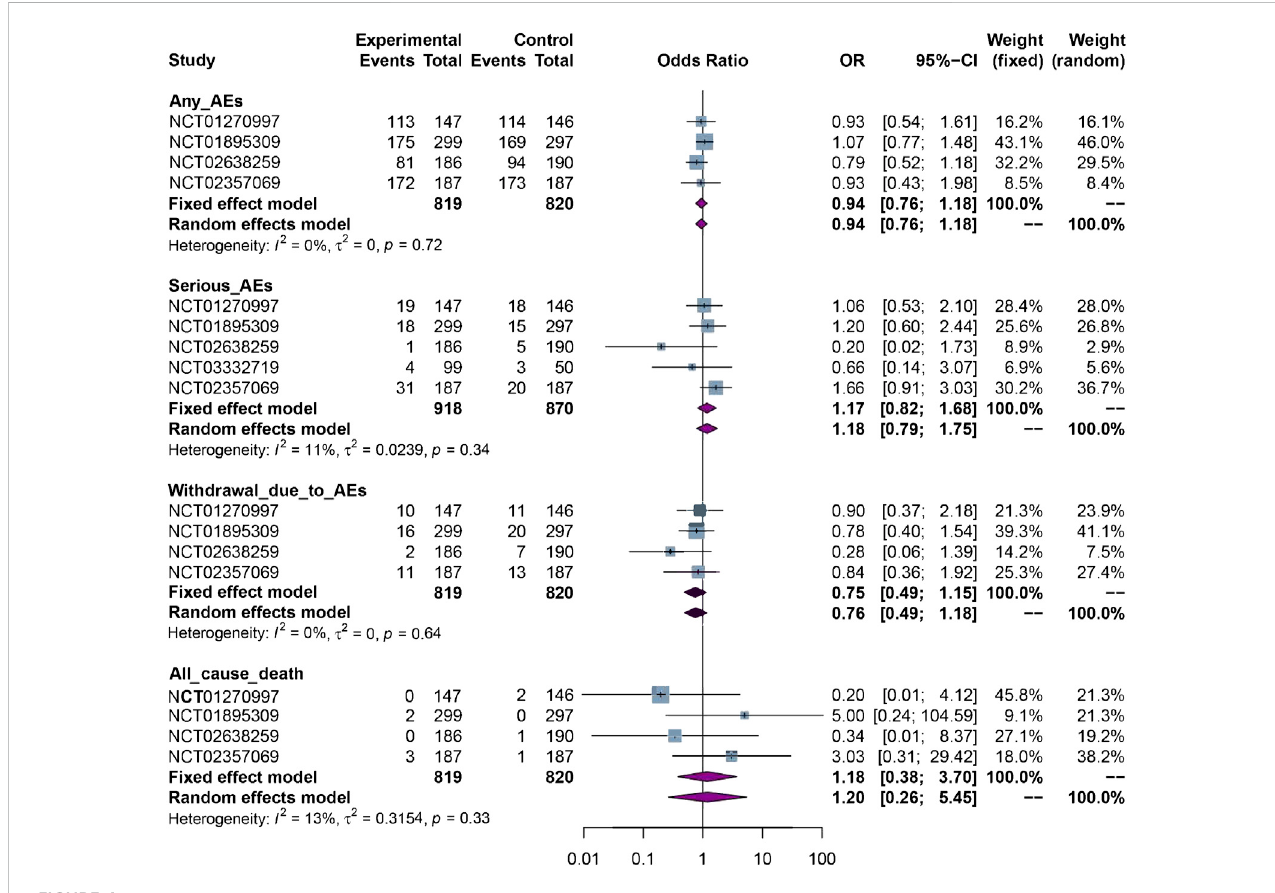
FIGURE 4 The forest plots of safety assessment. AEs: adverse events.